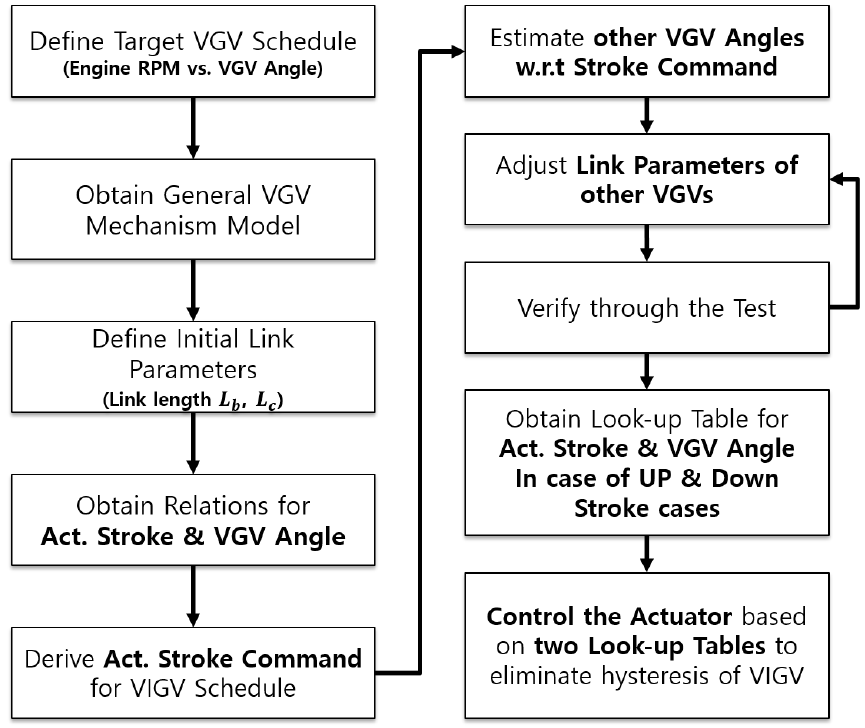
Figure 8. VGV scheduling methodology flow chart.